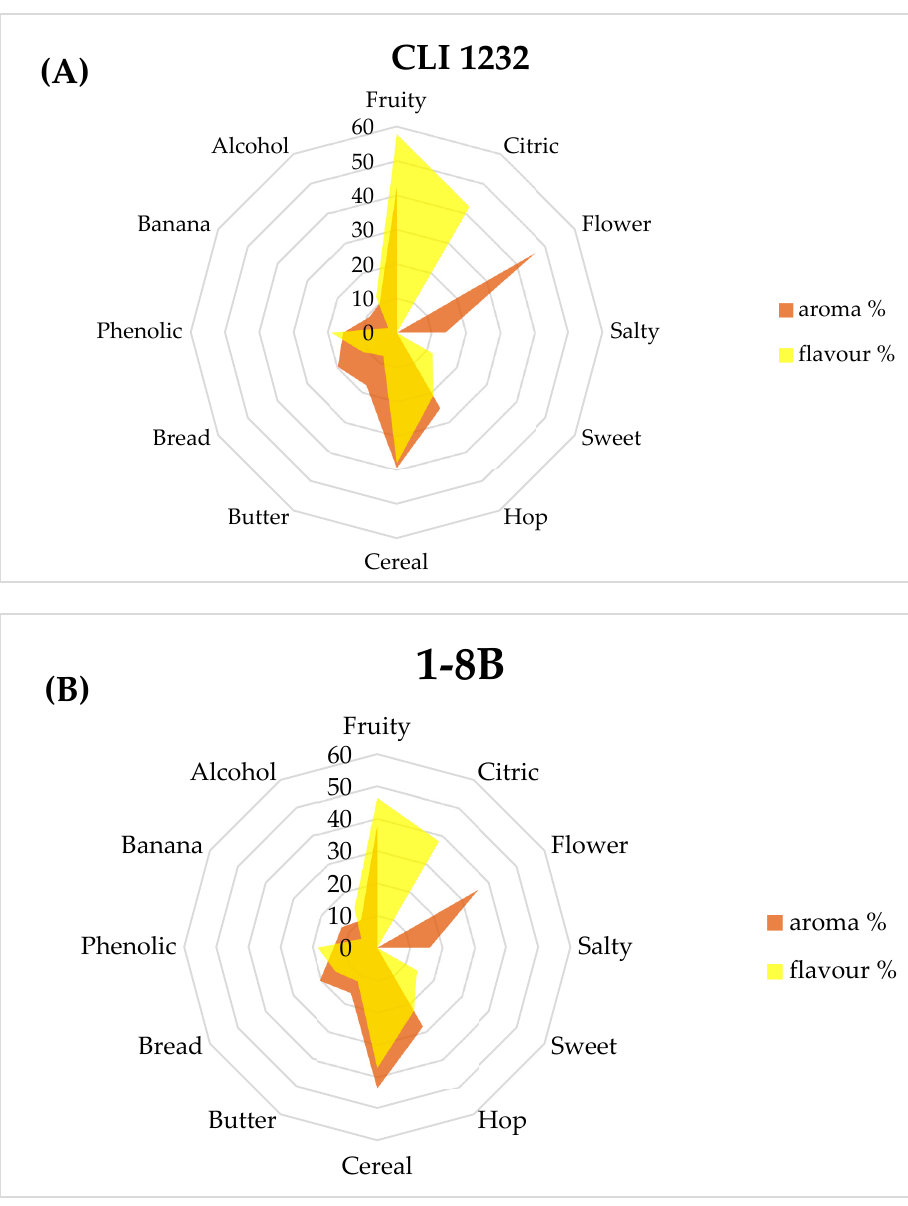
Figure 6. Percentage of detection by consumers for each of the analysed attributes in aroma and flavour for the sour beers (CLI 1232, 1-8B). ( A ): beer fermented with CLI 1232 strain. ( B ): beer fermented with 1-8B strain.